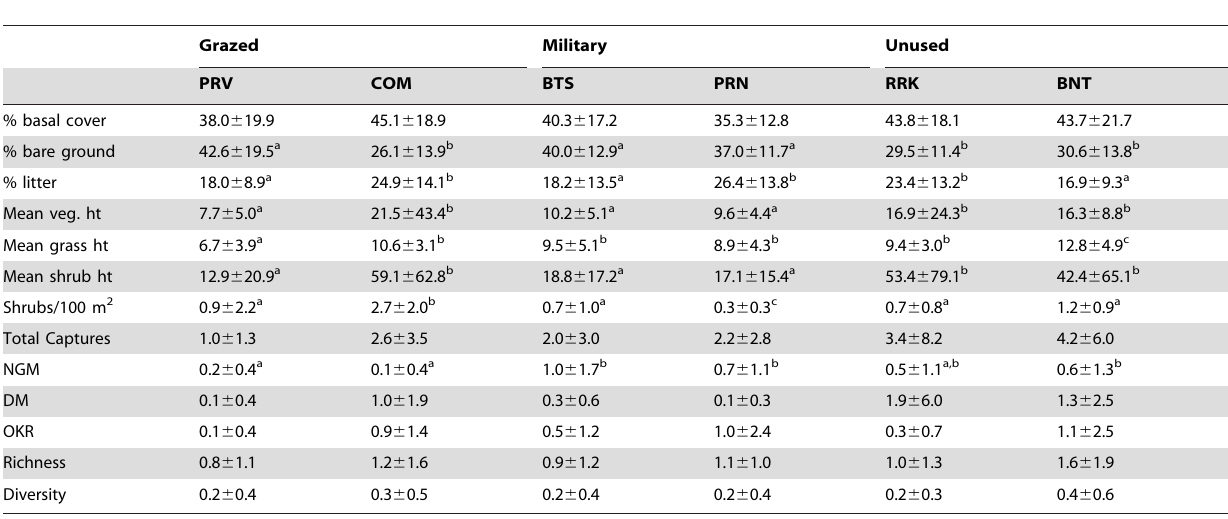
Table 2. Mean ( 6 SD) vegetation structure and small mammal population parameters for 6 study sites in southeastern Colorado, USA, 2001–2004.